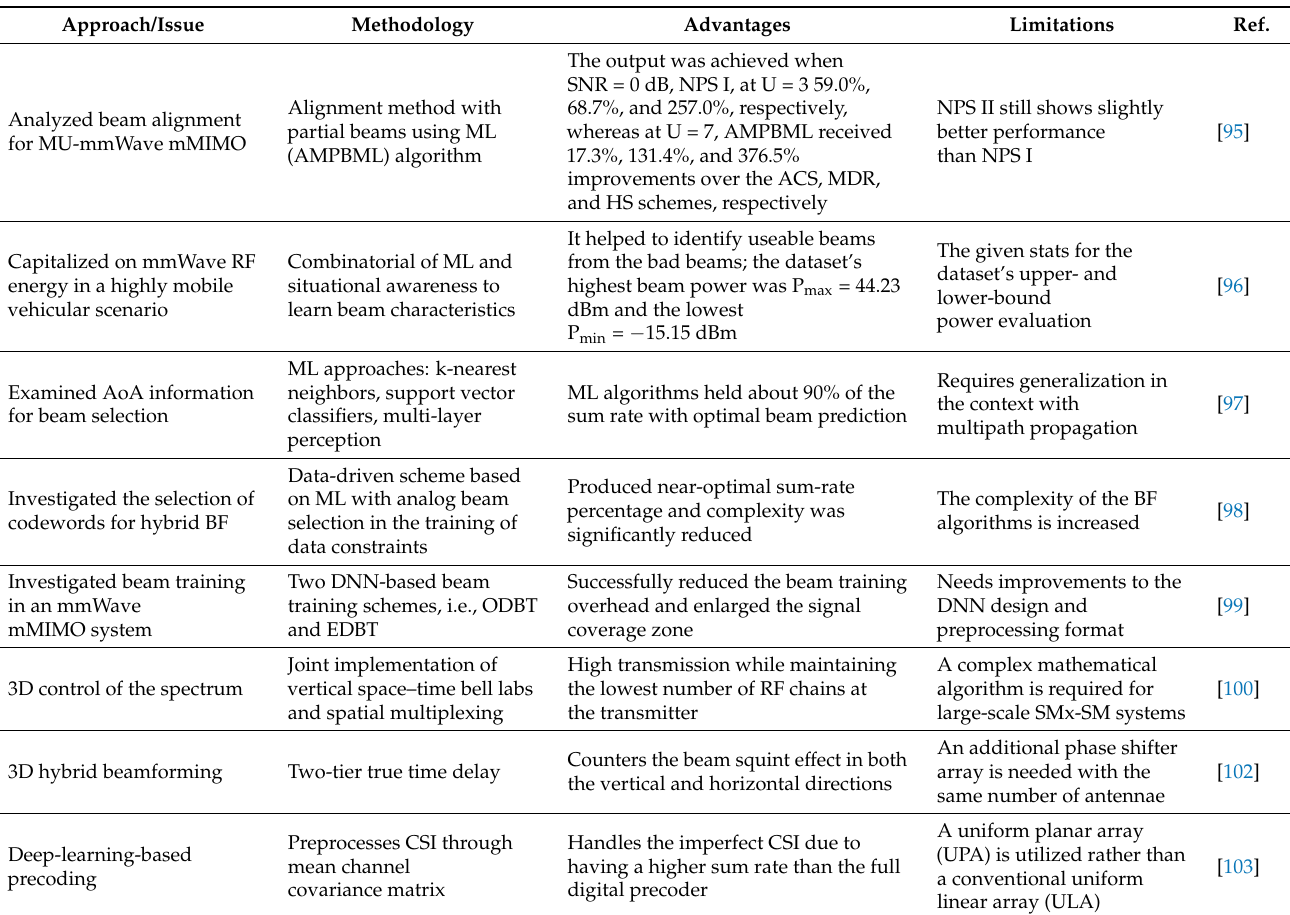
Table 5. A summary of the beam management techniques in BF-mmWave-mMIMO systems with